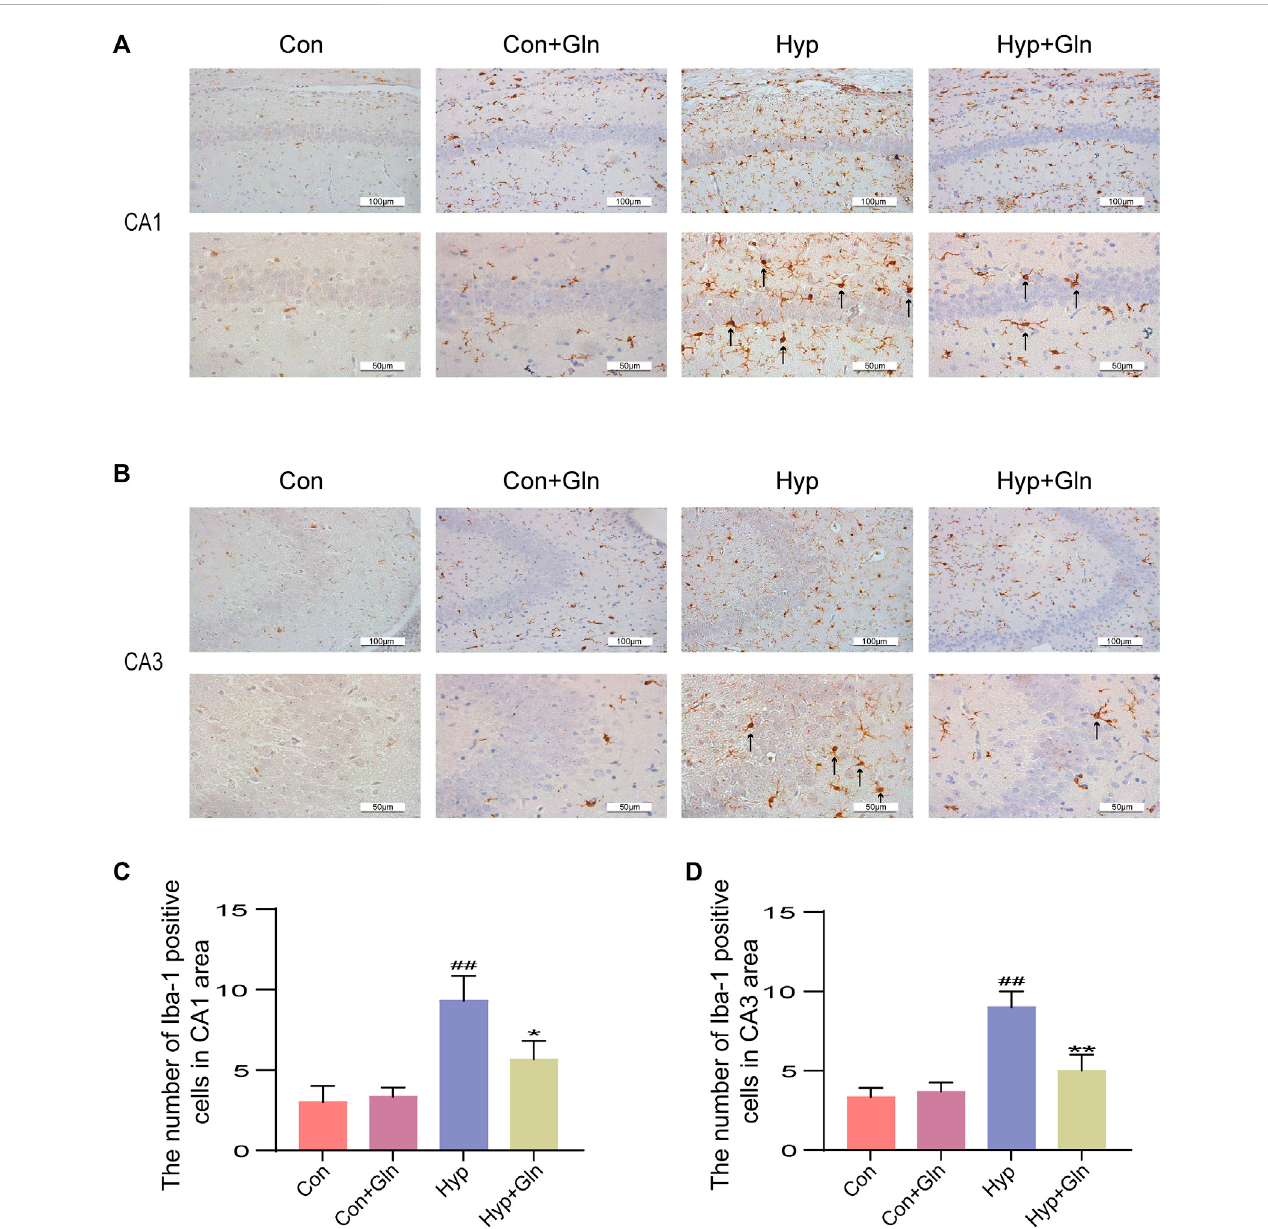
FIGURE 4 Glninhibitsmicrogliaactivationcausedbyhyperoxia. (A) Activationofmicrogliainthehippocampus(CA1)ofeachgroup. (B) Activationofmicrogliainthe hippocampus (CA3) of each group. (C) Quanti fi cation of activated microglia (CA1). Con (3.00 ± 0.58), Con + Gln (3.33 ± 0.33), Hyp (9.33 ± 0.88), Hyp + Gln (5.67±0.67) (D) Quanti fi cationofactivatedmicroglia(CA3).Con(3.33±0.33),Con+Gln(3.67±0.33),Hyp(9.00±0.58),Hyp+Gln(5.00±0.58)( n =3). ## p < 0.01 vs. the Con. * p < 0.05, ** p < 0.01 vs. the Hyp. p < 0.05 was considered statistically signi fi cant. Activated microglia were marked by black